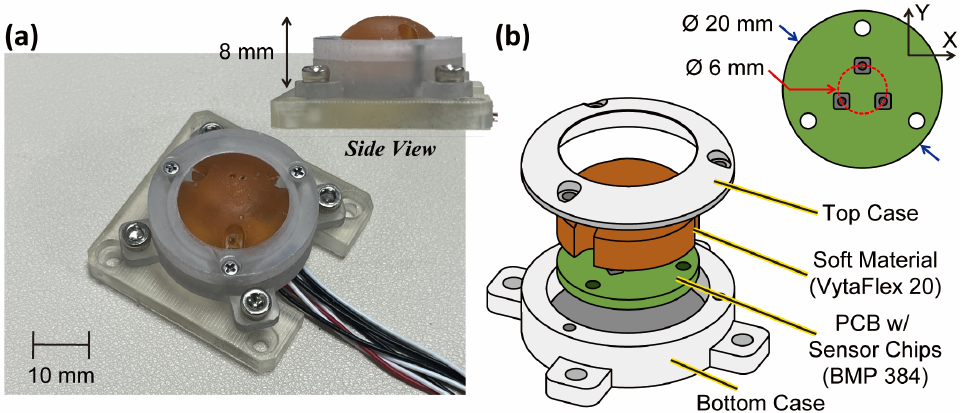
Figure 1. ( a ) Picture of the proposed sensor (asymmetric view and side view). ( b ) Exploded view with dimensions.